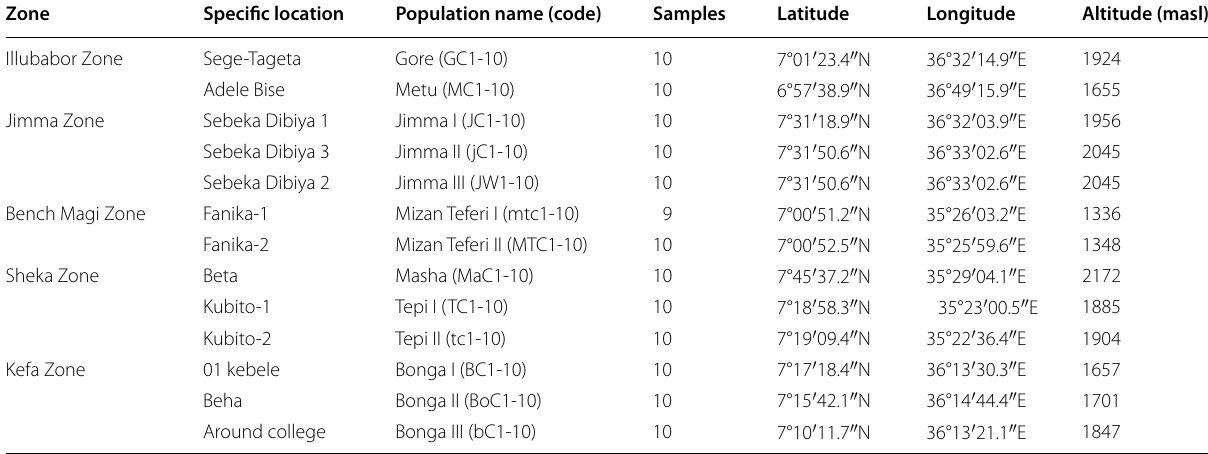
Zone is a collection of Woredas together; the GPS system used was universal transverse mercator coordinates (UTM)